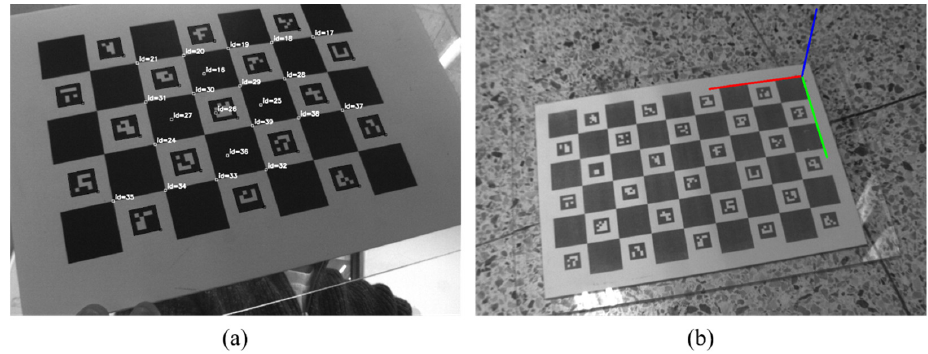
Figure 4. ( a ) Intrinsic calibration and ( b ) Extrinsic calibration.